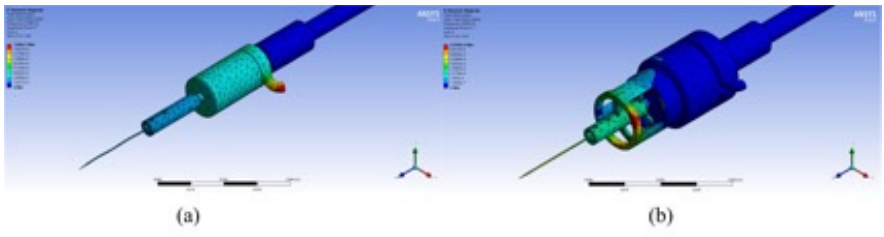
Figure 5. Deformation nephogram under optimal parameters of the two devices: ( a ) Deformation nephogram of the microdissection device with flexure mechanism under optimal vibration condi- tions; ( b ) deformation nephogram of traditional structure microdissection device under optimal vibration conditions.